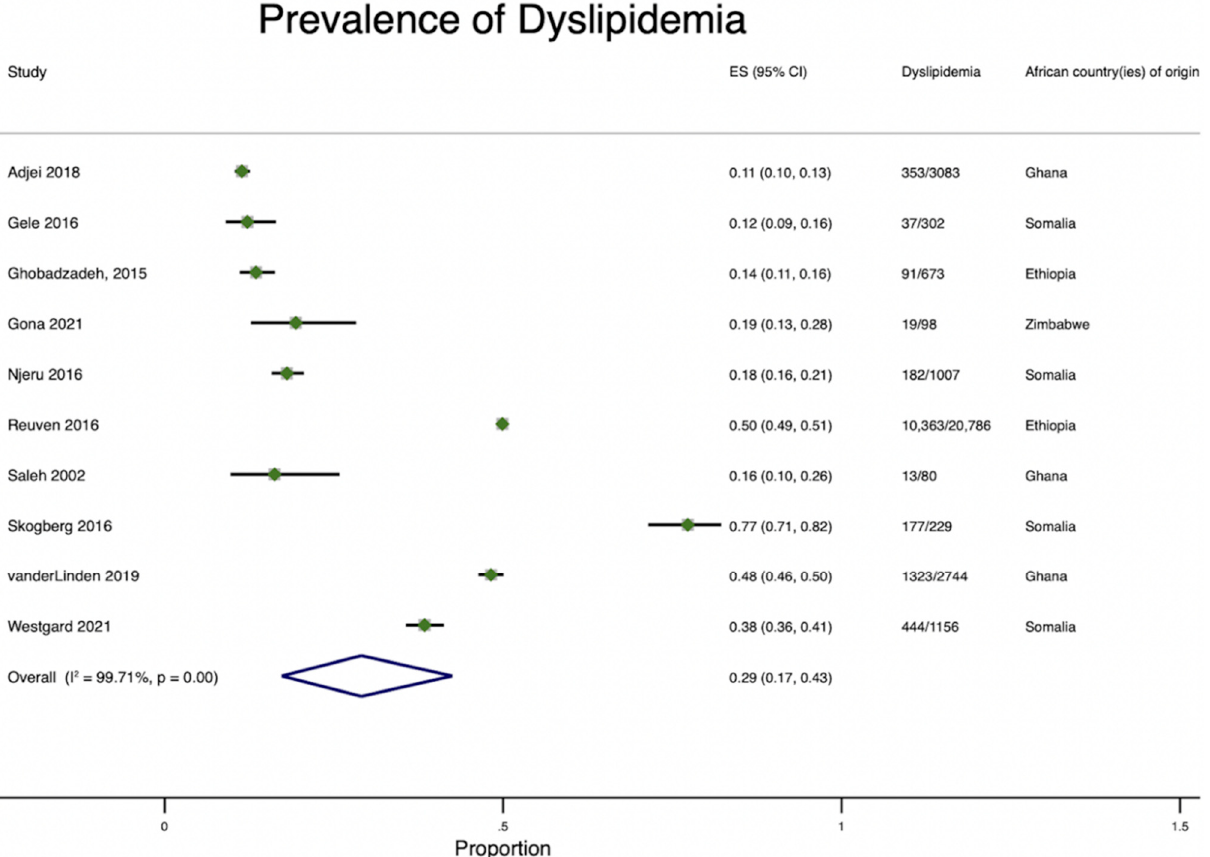
Figure 7. Pooled Prevalence of dyslipidemia among African immigrants residing in high-income